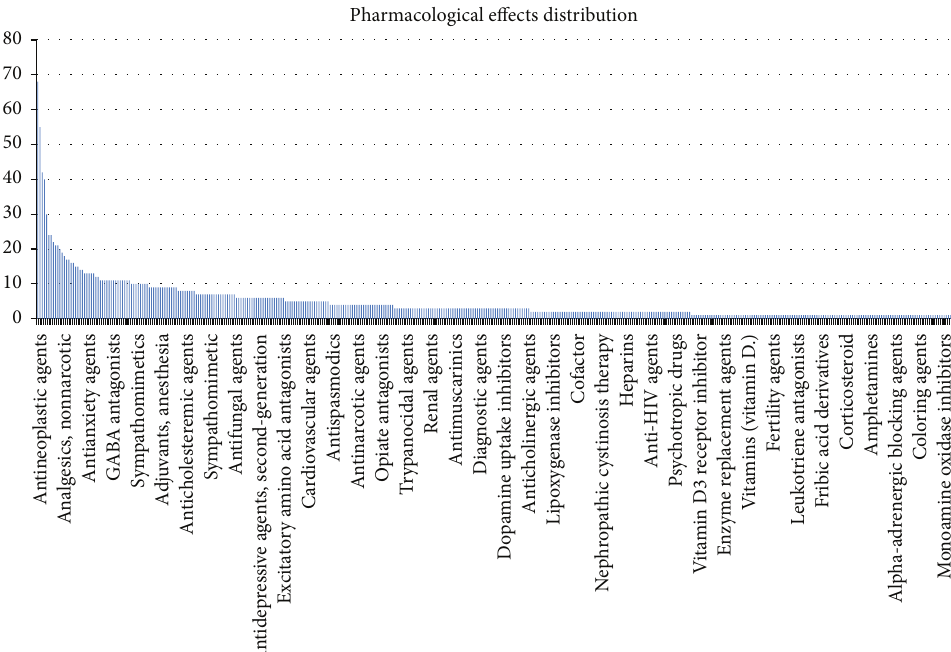
Figure 4: The pharmacological distribution of all 112 components in